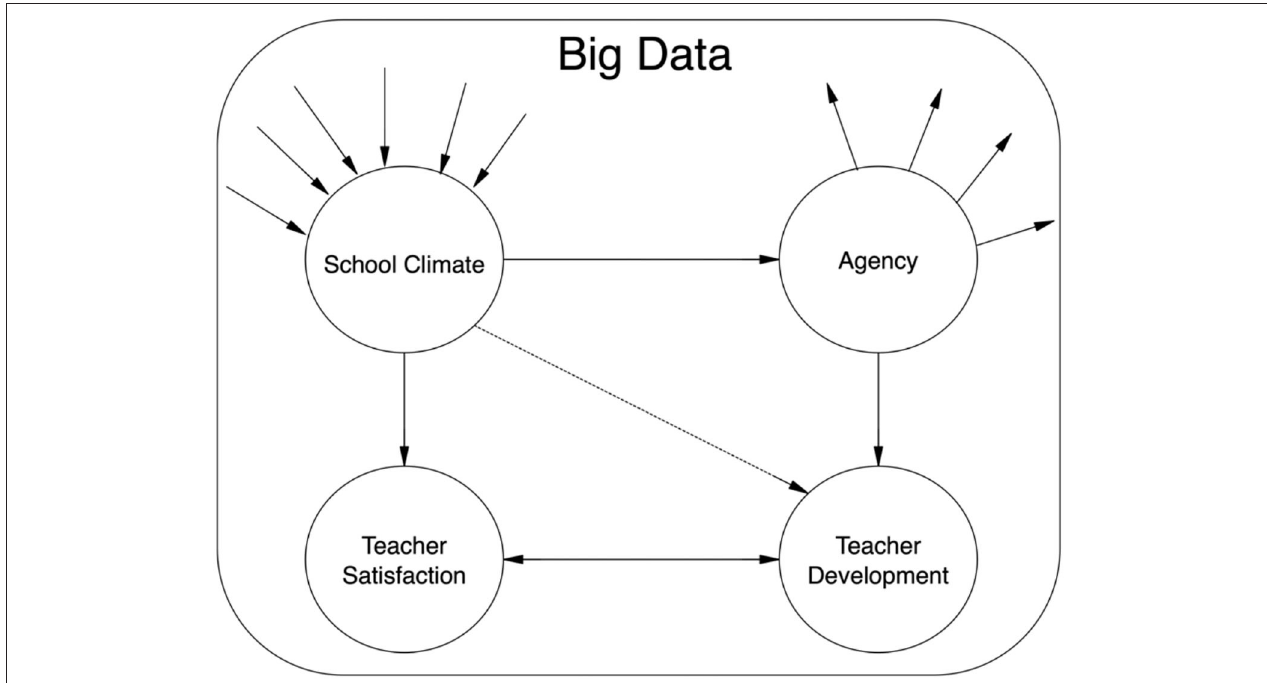
FIGURE 16 | Relations of teacher